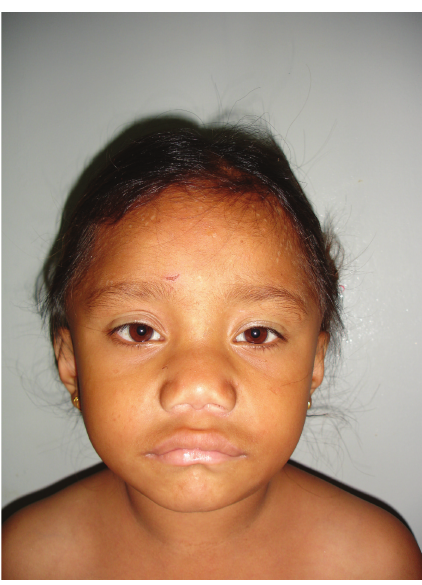
Figure 2: Facial features in the same girl with Kocher-Debre- Semelaigne syndrome.